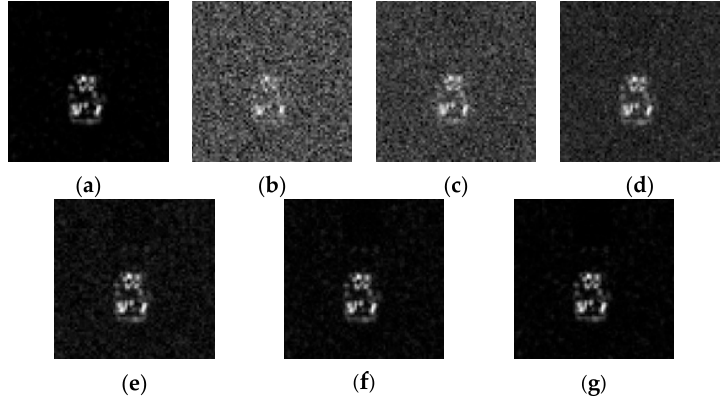
Figure 15. SAR images with different SNRs: ( a ) original image; ( b ) 0 dB; ( c ) 10 dB; ( d ) 20 dB; ( e ) 30 dB; ( f ) 40 dB; ( g ) 50 dB.